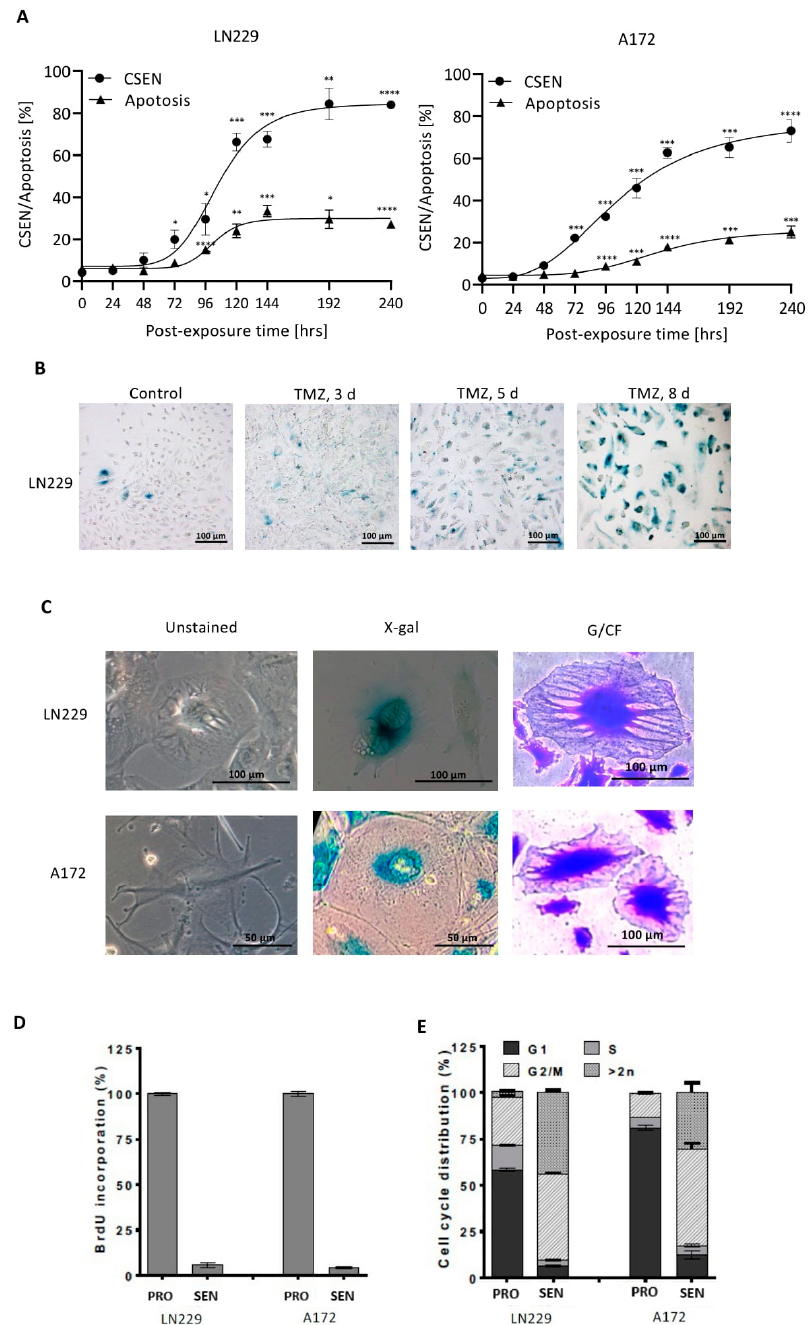
Figure 1. Kinetics of induction of apoptosis and CSEN in LN229 and A172 glioblastoma cells. ( A ) Kinetics of senescence and apoptosis following TMZ (50 µM treatment). Each measurement point represents the mean of at least three independent experiments, each performed in duplicate. Significance levels are indicated. * p < 0.05, ** p < 0.01, *** p < 0.001; **** p < 0.0001 ( B ) Images of LN229 cells: nontreated control after 5 days, and TMZ-treated populations 3, 5, and 8 days after addition of TMZ to the medium. ( C ) Images of senescent cells 8 days after treatment (50 µ M TMZ) not stained and stained with X-Gal. Righthand site: Representative examples of senescent LN229 cells (giant cell morphology) stained with Giemsa/Carbol Fuchsin (G/CF). ( D ) DNA replication in proliferating (con) and TMZ-treated senescent population, measured 6 days after treatment. ( E ) Cell-cycle distribution of proliferating (con) and TMZ- induced senescent cells, measured 120 h after